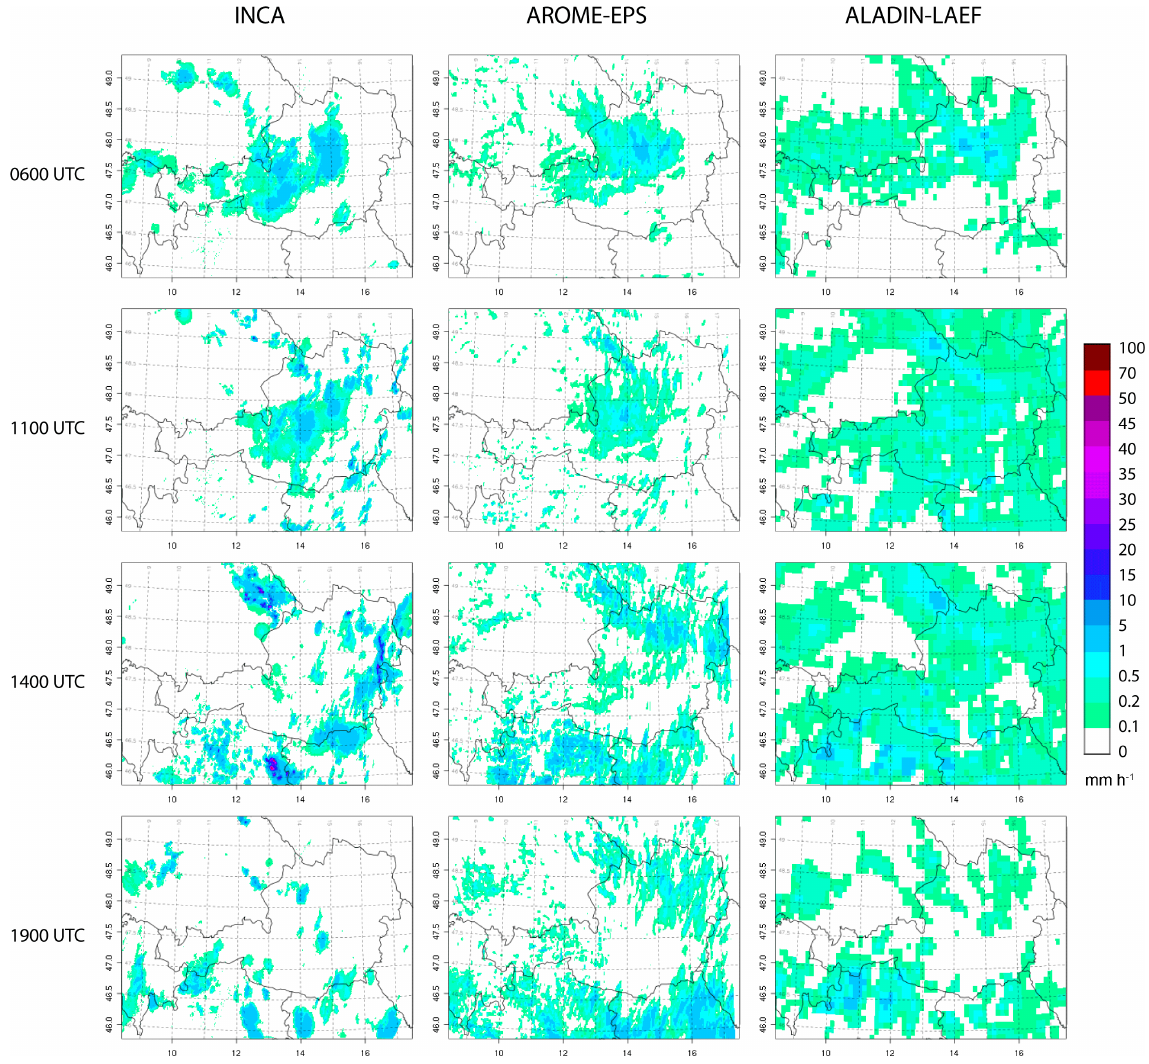
Figure 11. Observed (INCA, first column) and forecast (AROME-EPS and ALADIN-LAEF, second and third columns, respectively) de- velopment of precipitation on 29 April 2014 shown for selected times (rows). The panels show 1-hourly accumulated precipitation sums